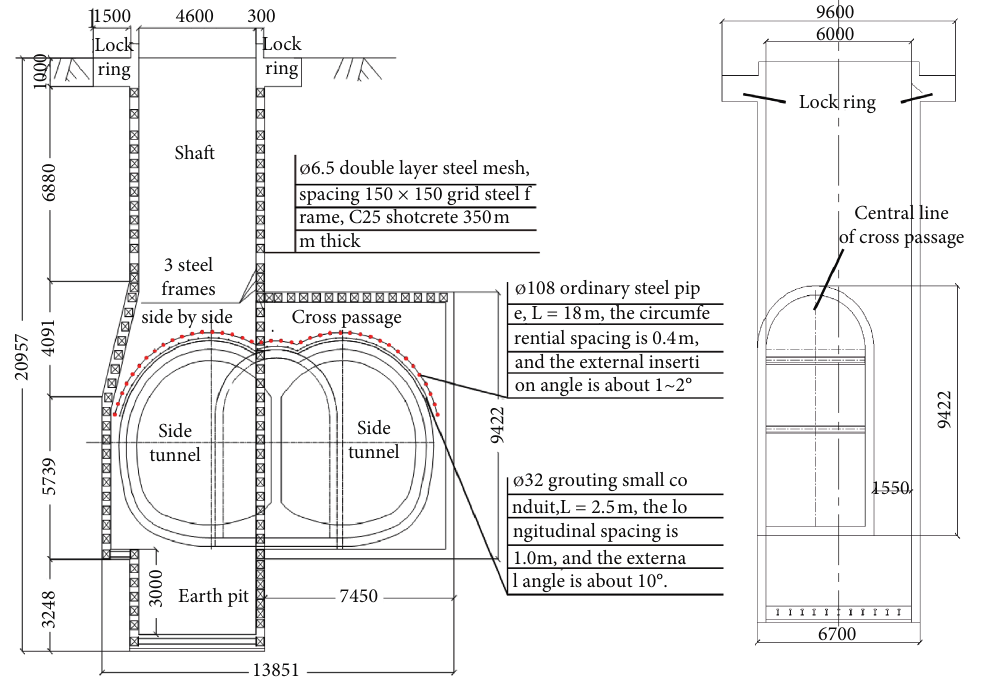
Figure 4: Design drawing of shaft and transverse passage to the section tunnel (unit: